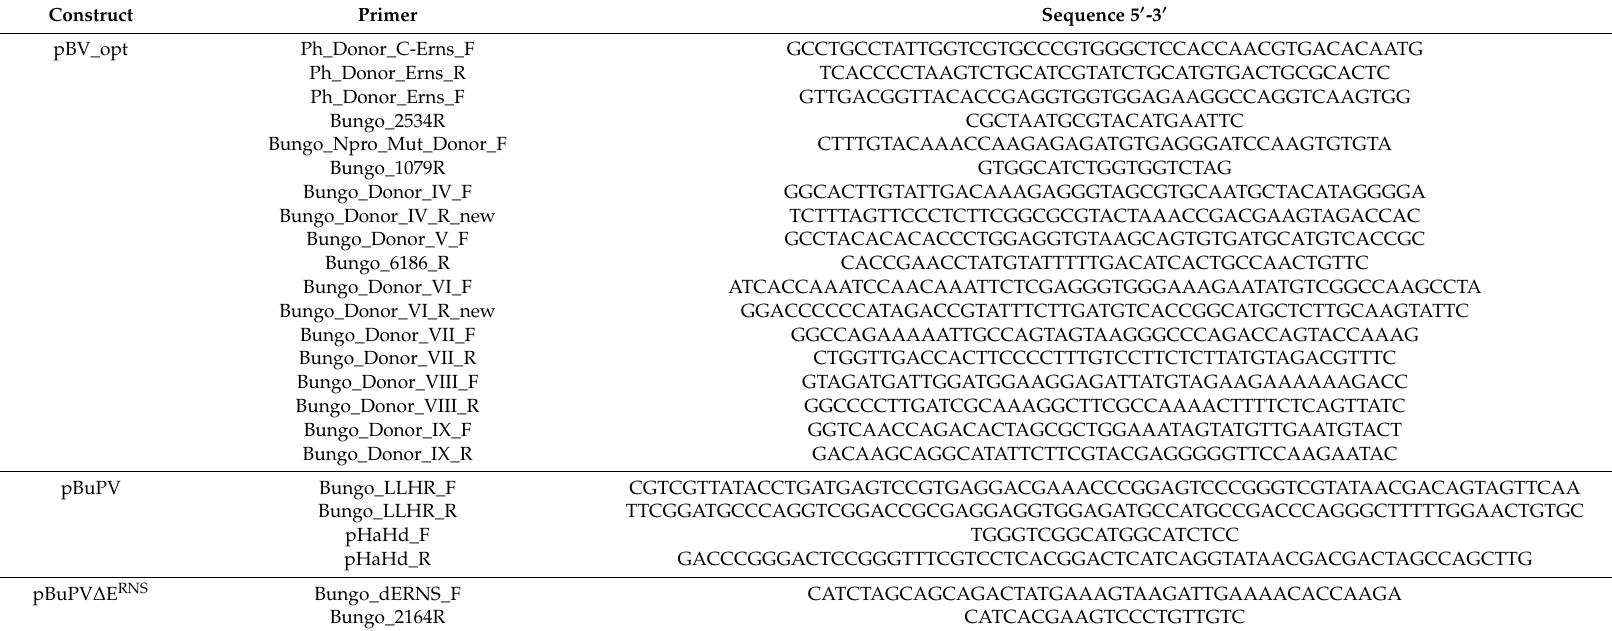
Table 1. Primer sequences for plasmid